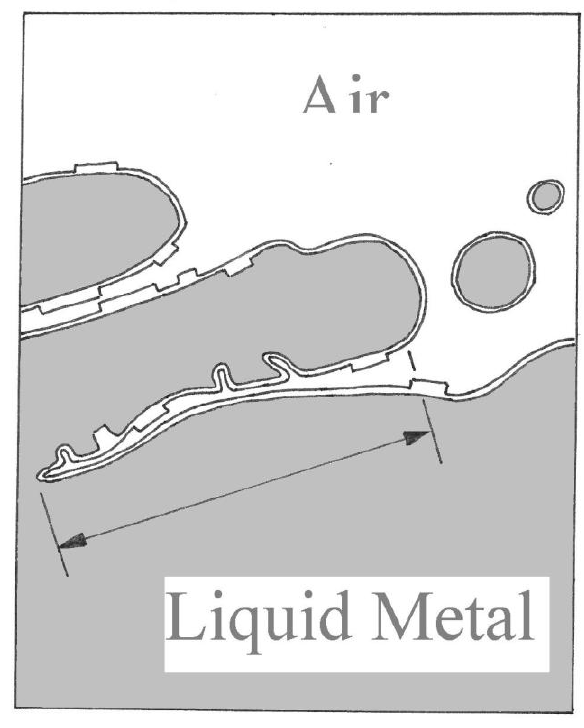
Figure 1. Creation of bifilms by surface turbulence.